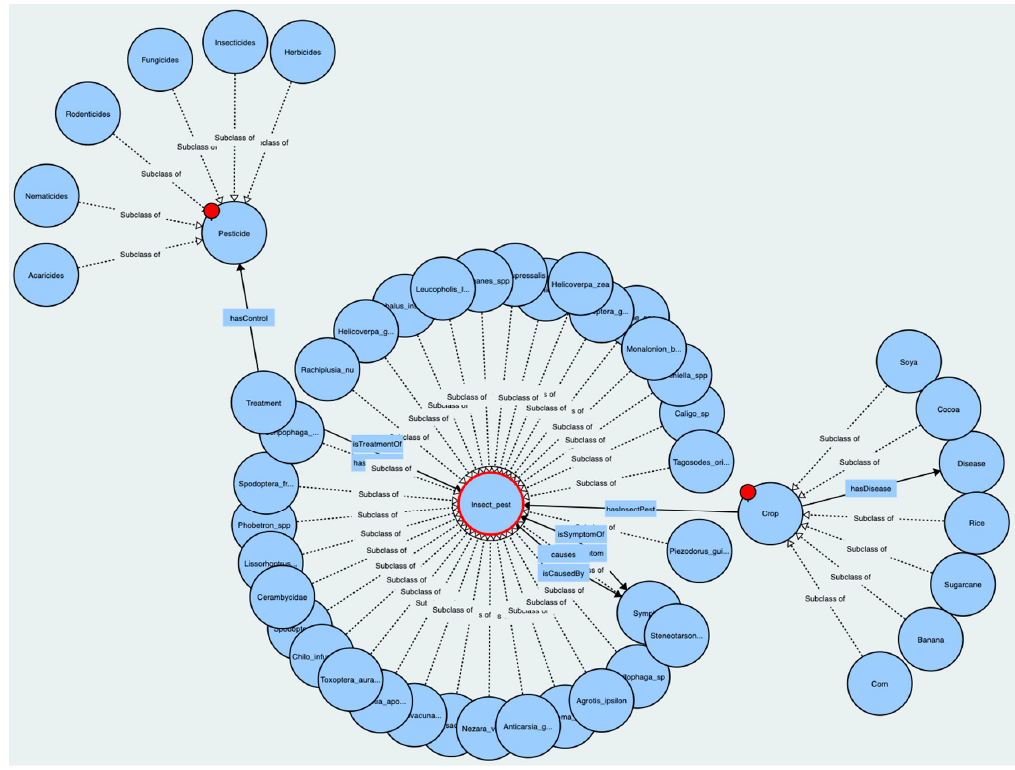
Figure 2 . An excerpt from the AgriEnt-Ontology. Figure 2. An excerpt from the AgriEnt-Ontology.